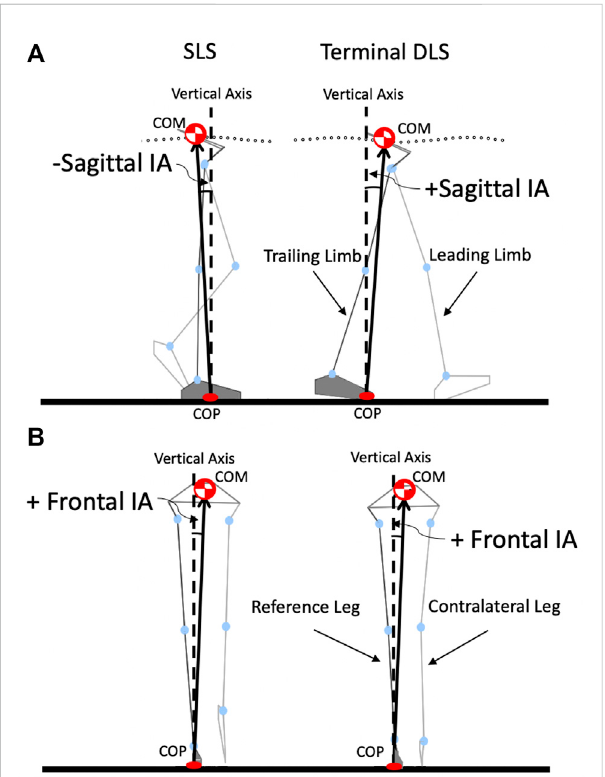
Schematic diagram showing a stick fi gure of a typical participant during level walking showing the COM and COP, and the COM-COP vector forming the sagittal inclination angle (IA) (A) and frontal IA (B) with the vertical. The reference limb is shown in darker